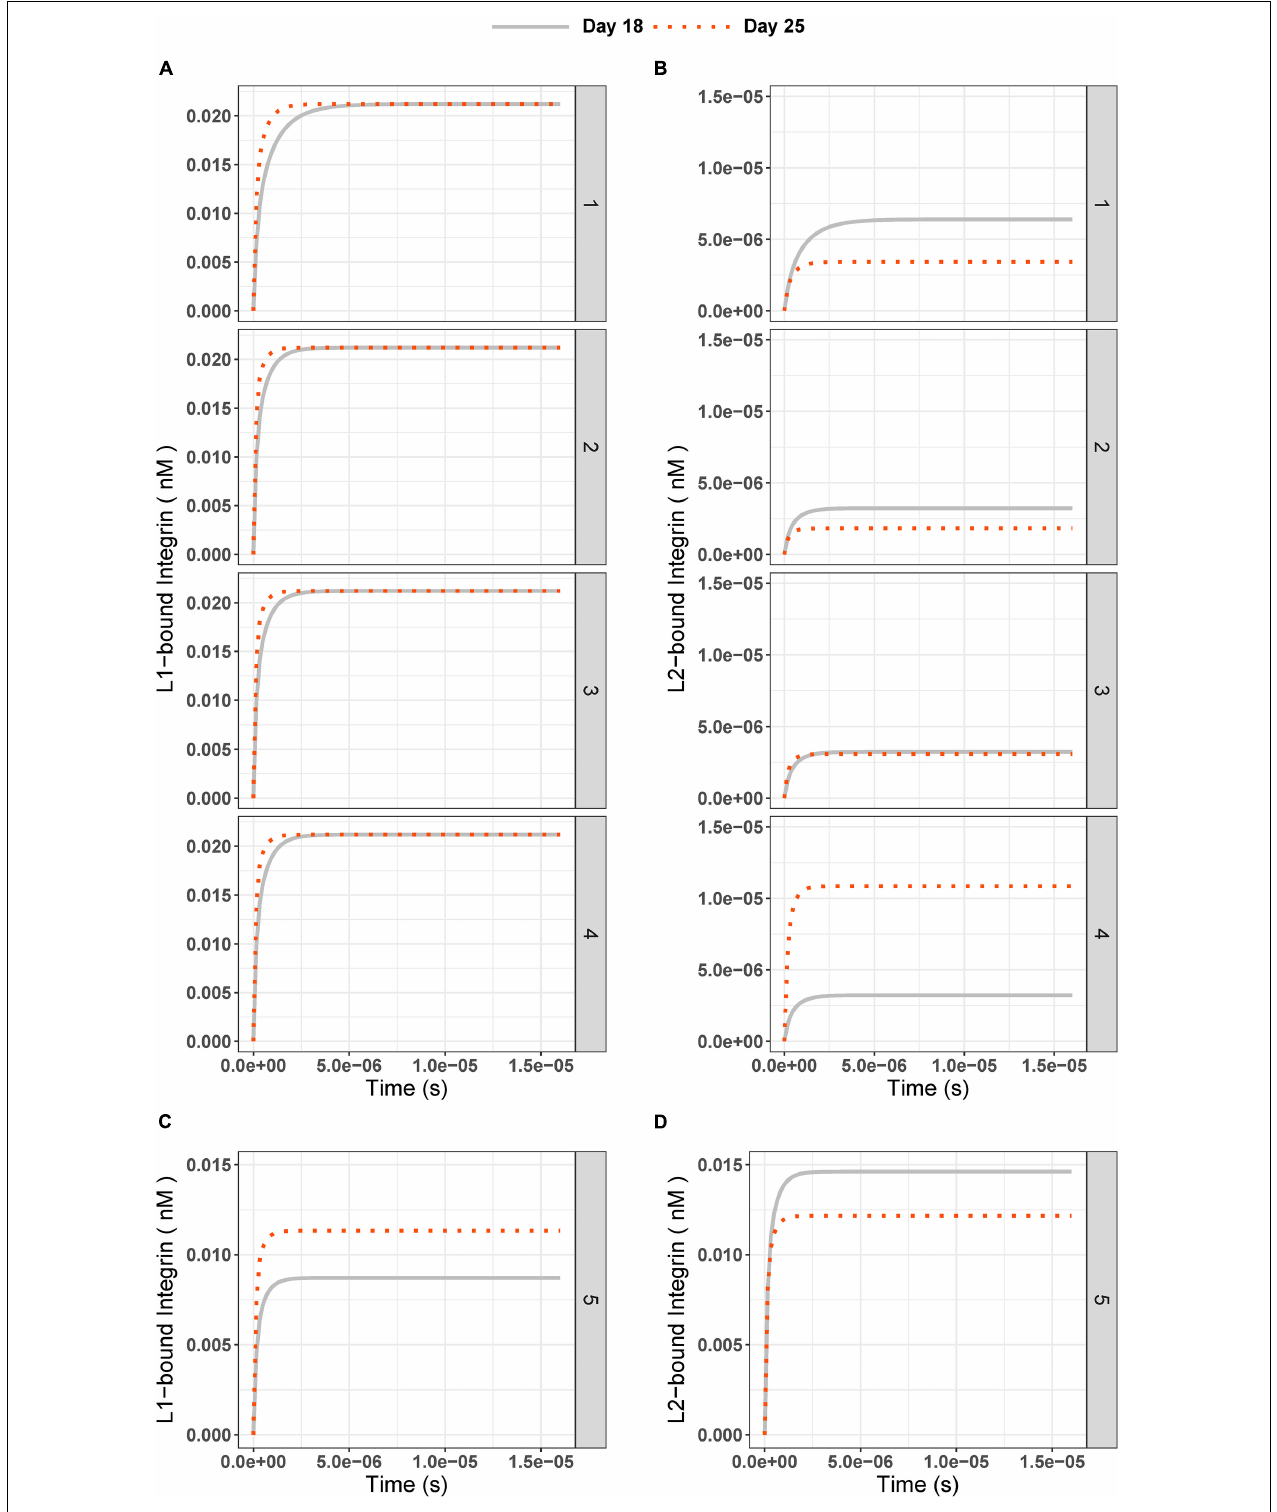
FIGURE 3 | (A) L 1-bound and (B) L 2-bound integrin concentrations over time in experiment days 18 (gray solid line) and 25 (red dotted line) for test conditions 1 to 5. The test conditions are as given in Table 2 and Figure 2 : (1) Different IC are 0.18 nM for L 1, 0.33 nM for L 2; (2) Different FC are 2.5 for L 1, 1.5 for L 2; (3) Equal IC is 0.33 nM; Equal FC is 2.5; and (4) High FC for L 2 is 9. (C) L 1-bound and (D) L 2-bound integrin concentration over time for test condition 5 (Different IC and equal binding rate constants for ligands; k 3 = k 5 = 1.6 × 10 8 1/(nM × s), k 4 = k 6 = 3.5 × 10 − 1 1/s).